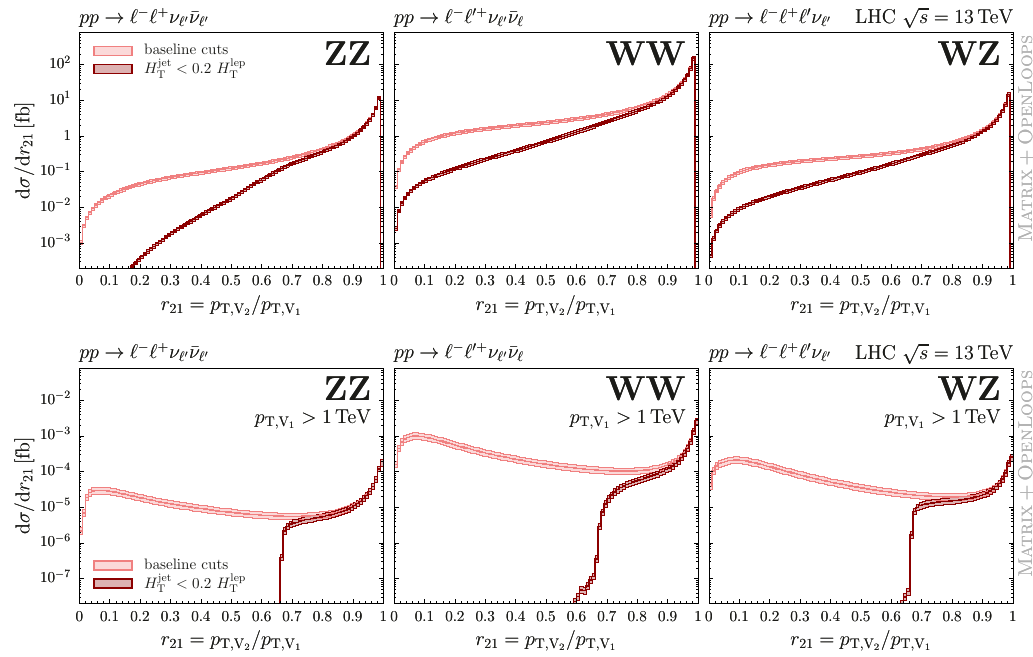
Figure 11 . Distribution in the ratio of the transverse momenta of the softer and the harder re- constructed vector bosons, r 21 = p T ; V =p T ; V , at NLO QCD for the processes (3.1){(3.3) at 13 TeV. 2 1 Baseline cuts are applied without (light red) and with (dark red) a jet veto. In the lower frames, an additional cut on the transverse momentum of the harder vector boson, p T ; V > 1 TeV is applied. 1 Actually, the average value of r 21 is well above 2/3 and exceeds 0.9, con(cid:12)rming that hard- V V production dominates. At large r 21 the distribution becomes logarithmically divergent, and the singularity is cancelled by the virtual contribution at r 21 = 1. Any tight cut in the vicinity of r 21 = 1 would induce large logarithmic corrections of soft and collinear